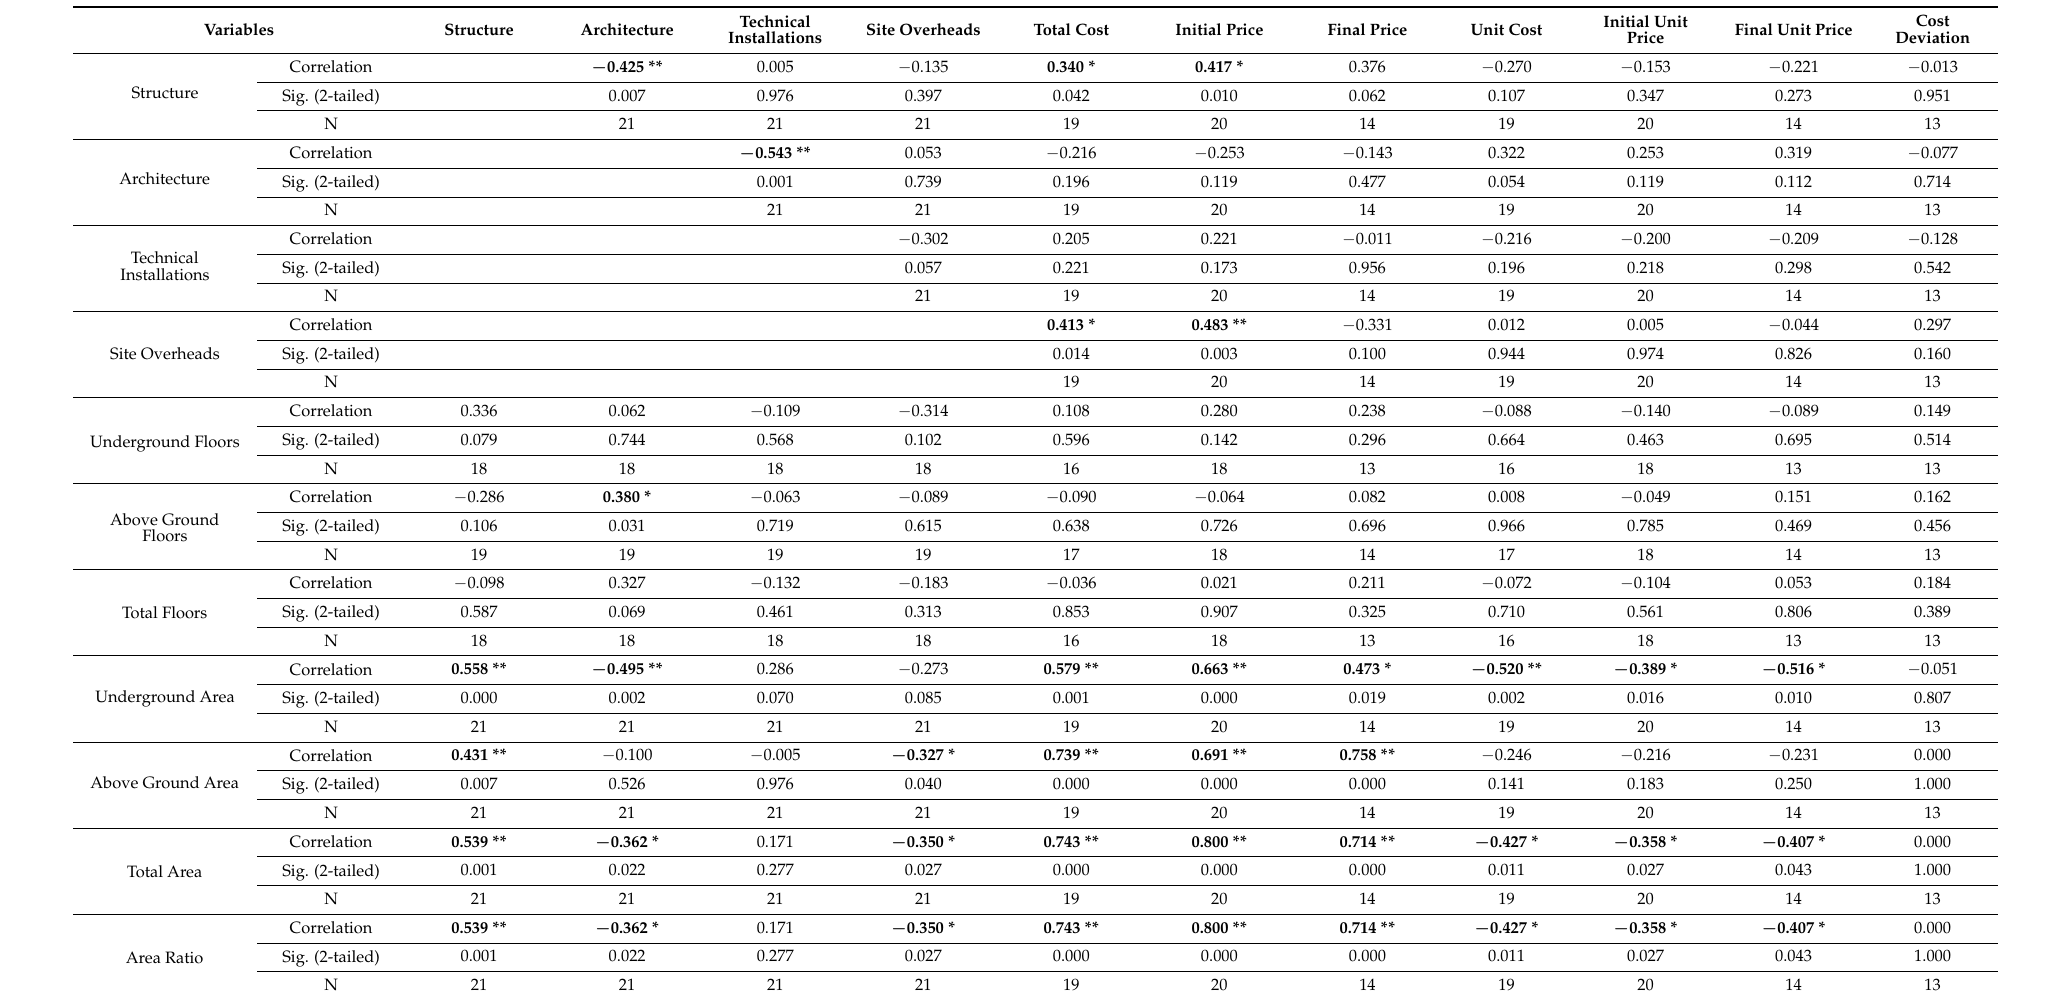
Table 5. Pearson correlation